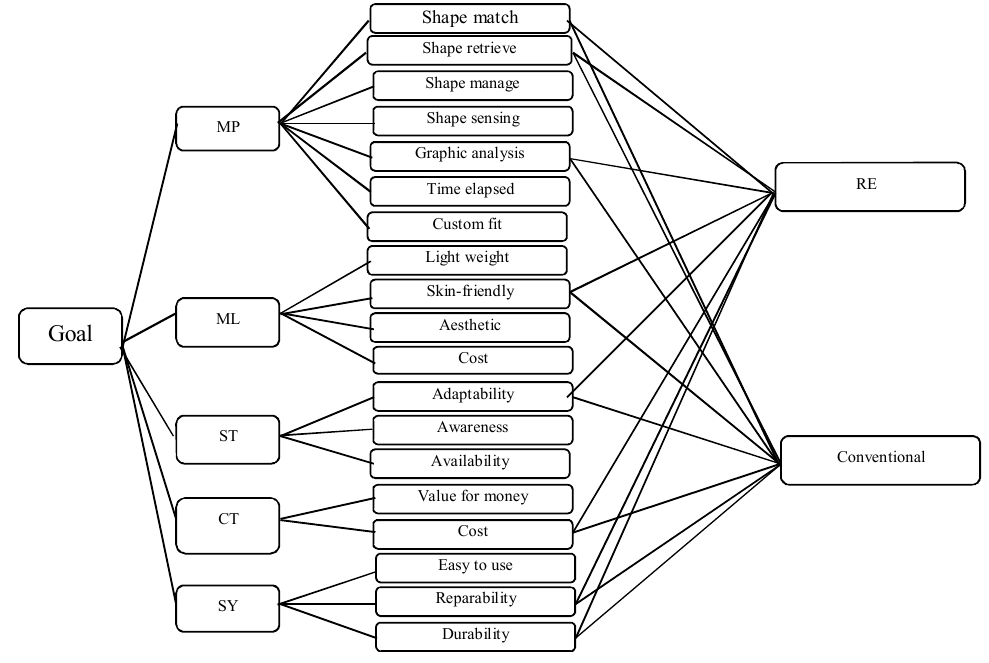
Fig. 2. Hierarchical representation for the selection of manufacturing